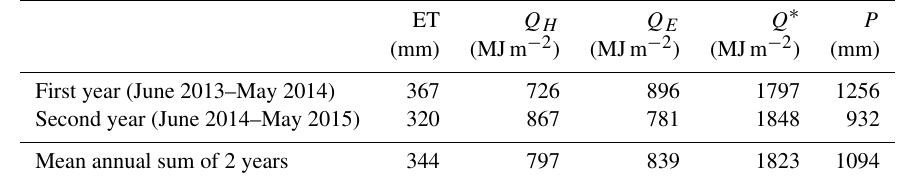
Table 3. Gap-filled annual budgets for surface energy fluxes and precipitation ( P ).